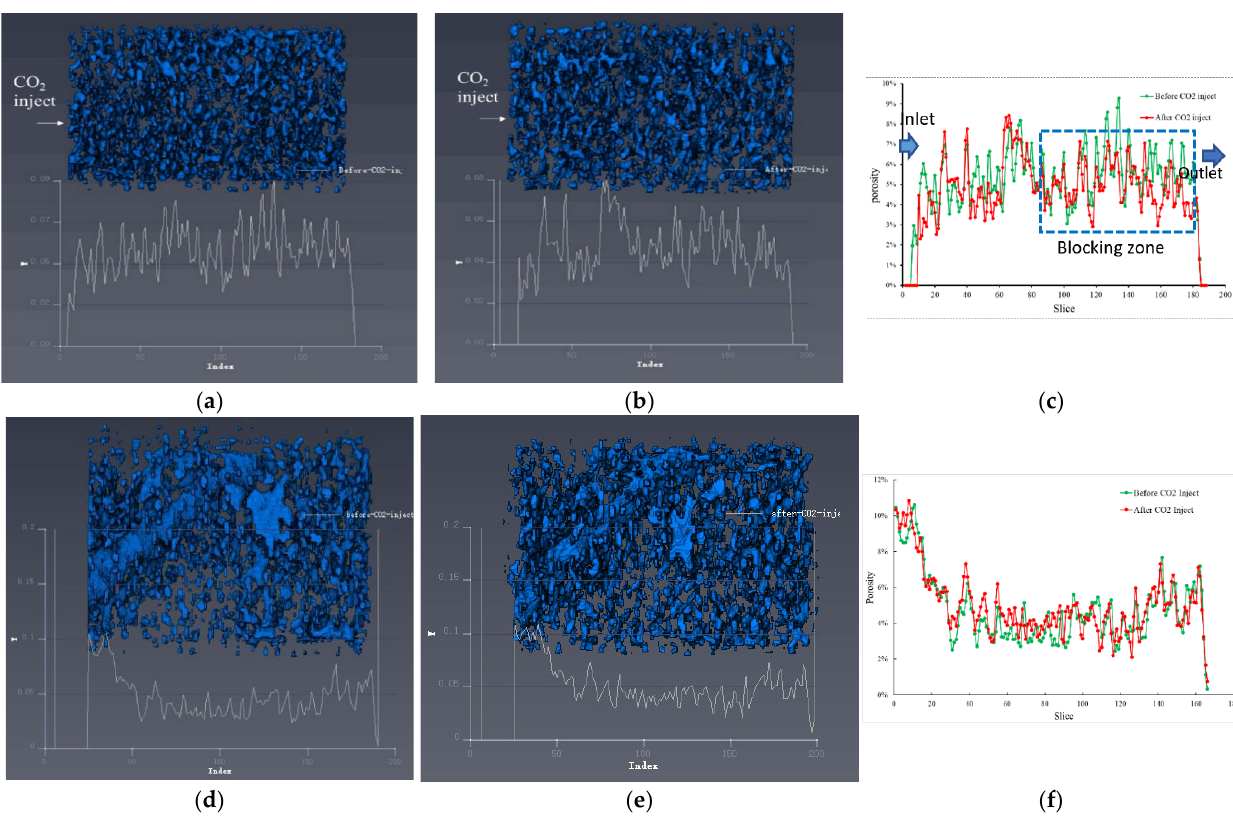
Figure 14. Comparison of porosity distribution. ( a ) C7 core before interaction. ( b ) C7 core after interaction. ( c ) Change of C7 core porosity. ( d ) S1 core before interaction. ( e ) S1 core after interaction. ( f ) Change of S1 core porosity. The helium porosimeter measured porosity of the S1 core is 5.28%. The reconstructed pore volume is 993,307 μm 3 , and the porosity reconstructed by CT scan is 5.37%. In Figure